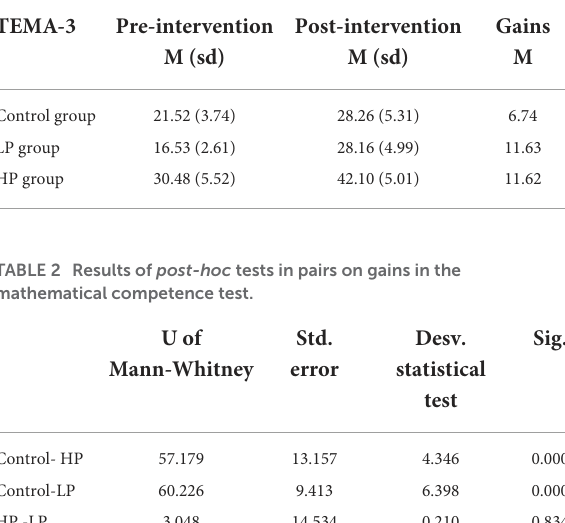
TABLE 3 Effect size on the mathematical competence test (pre/post-intervention).